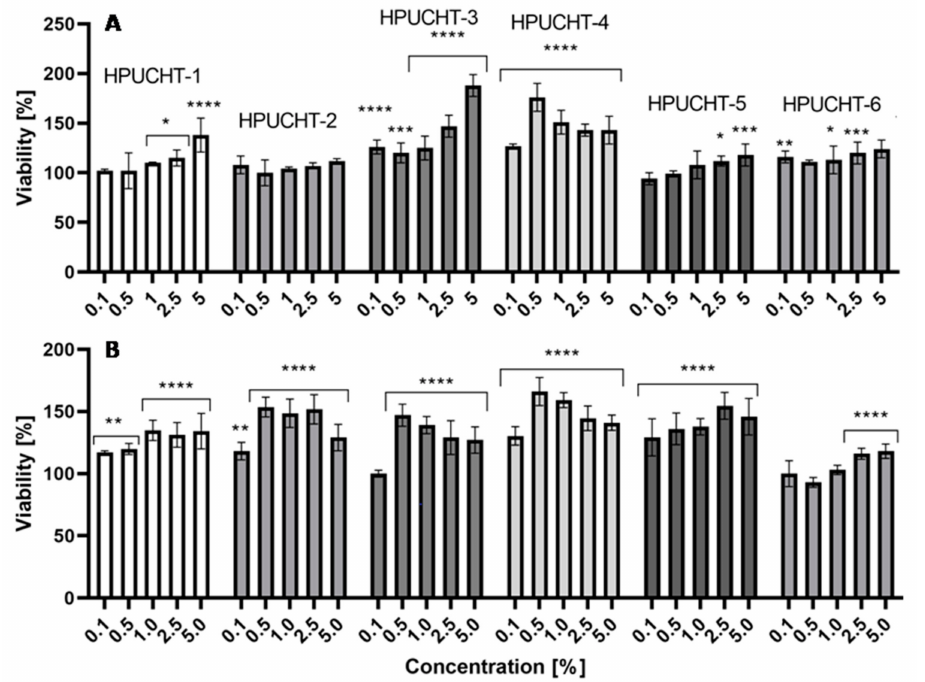
Figure 3. Effect of different concentrations of extracts (0.1–5%) from hydrogels on NR uptake in cultured fibroblasts after 2 h ( A ) and 24 h ( B ) of exposure. **** p ≤ 0.0001, *** p ≤ 0.001, ** p ≤ 0.01, * p ≤ 0.05 versus the control